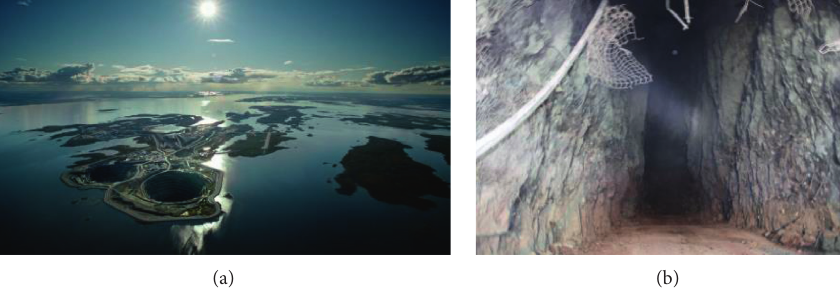
Figure 4: An aerial view of the diamond mine and a schematic diagram of mining kimberlite pillars [23].